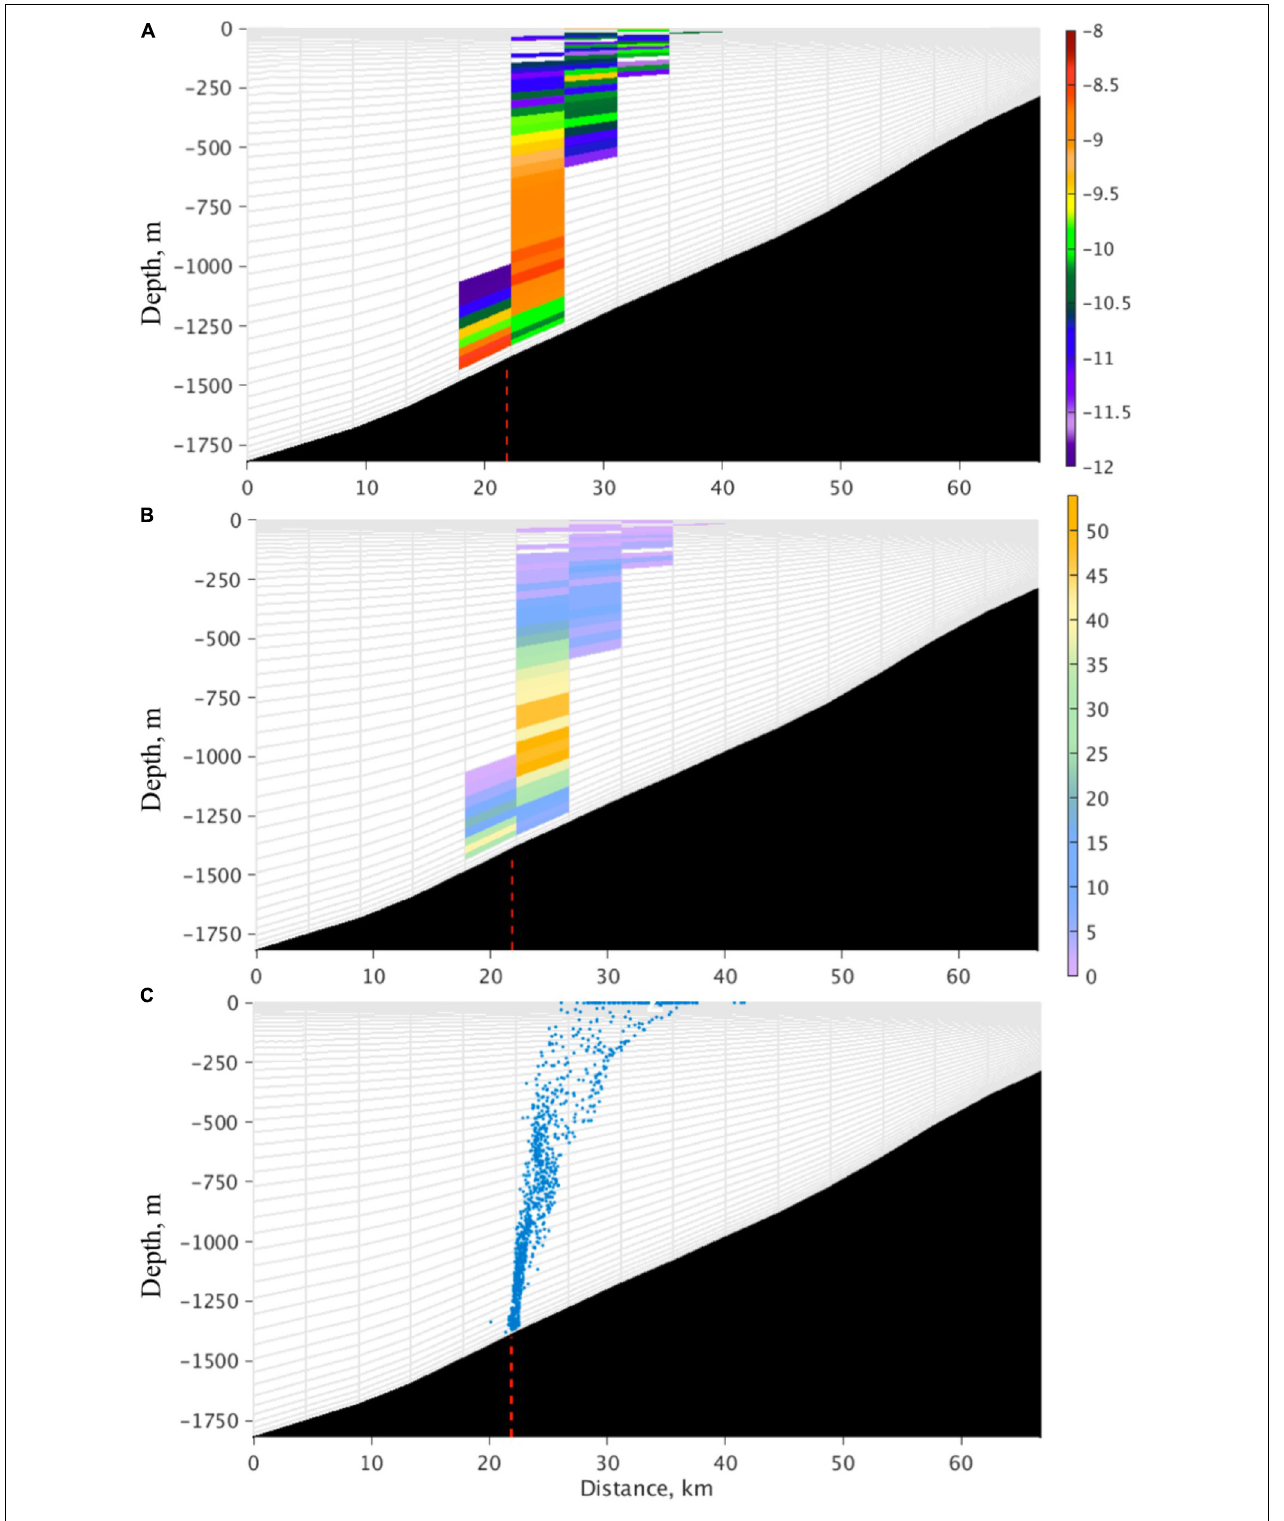
FIGURE 7 | LEM of oil characteristics in the vertical. (A) Vertical distribution of oil concentration ( C ∗ oil , kg m − 3 ) on natural logarithmic scale along section A, shown in Figure 6A . The grid cells are indicated with gray lines. (B) Vertical distribution of Lagrangian float counts in the grid cells. The fields shown in (A,B) are obtained by LEM. (C) Lagrangian float positions. The red dashed line indicates location of the DWH and the approximate release location of the floats.